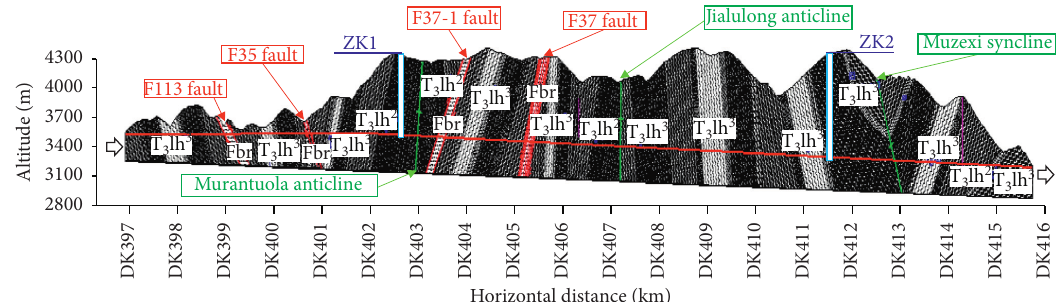
Figure 2: Borehole layout of the tunnel in Sichuan-Tibet